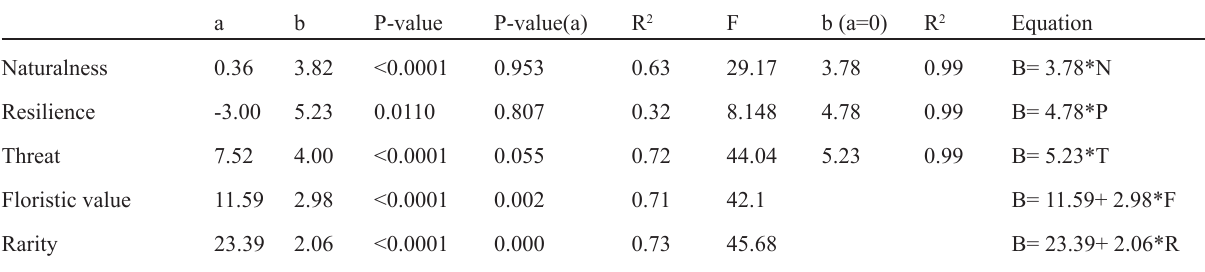
Table 5. Linear regression equations of Biological index vs. individual descriptors. (a) intercept coefficient and (b) is slope. When the elevation is not significant the equation y = bx is